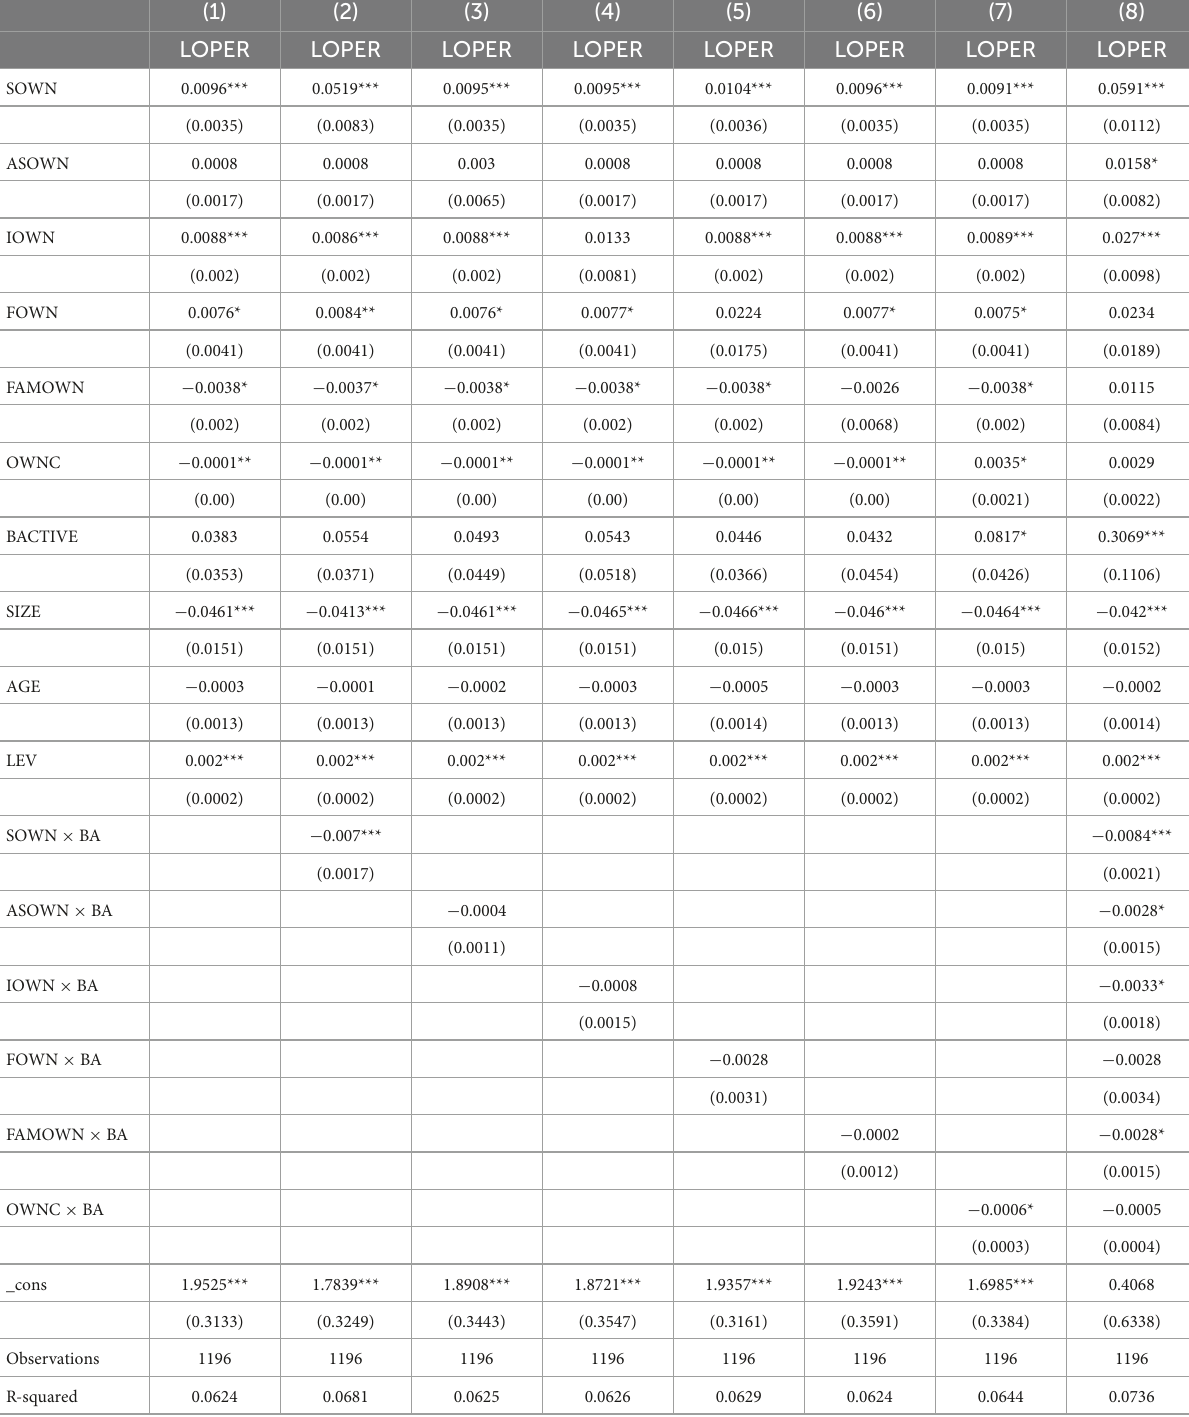
TABLE 4 Regression analysis of operating